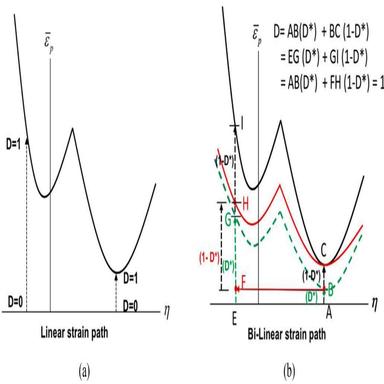
Damage index: (a) linear path and (b) bilinear path.